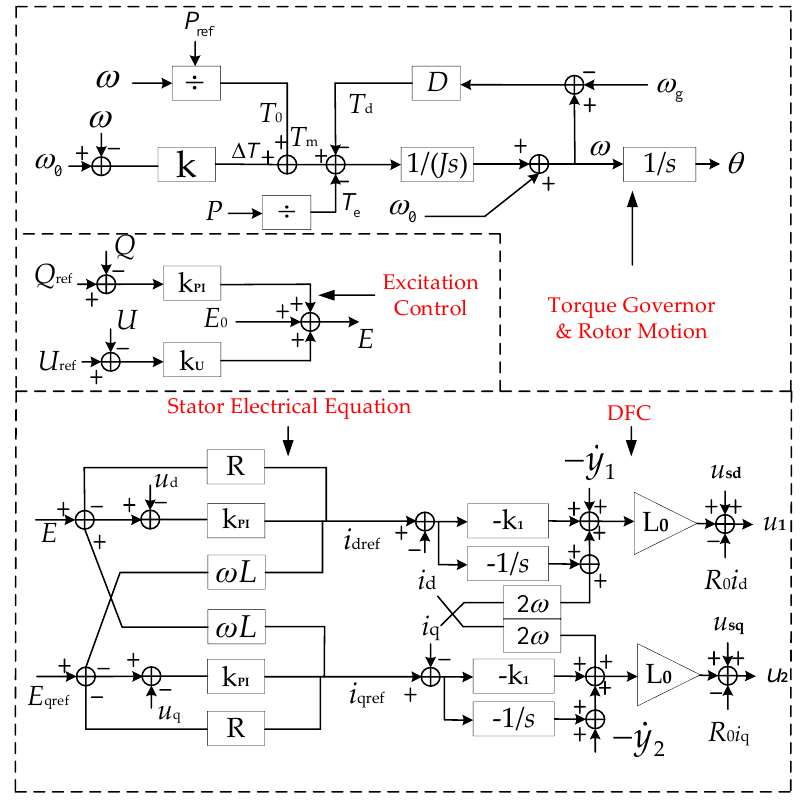
Figure 13. Control chart of VSG-DFC.